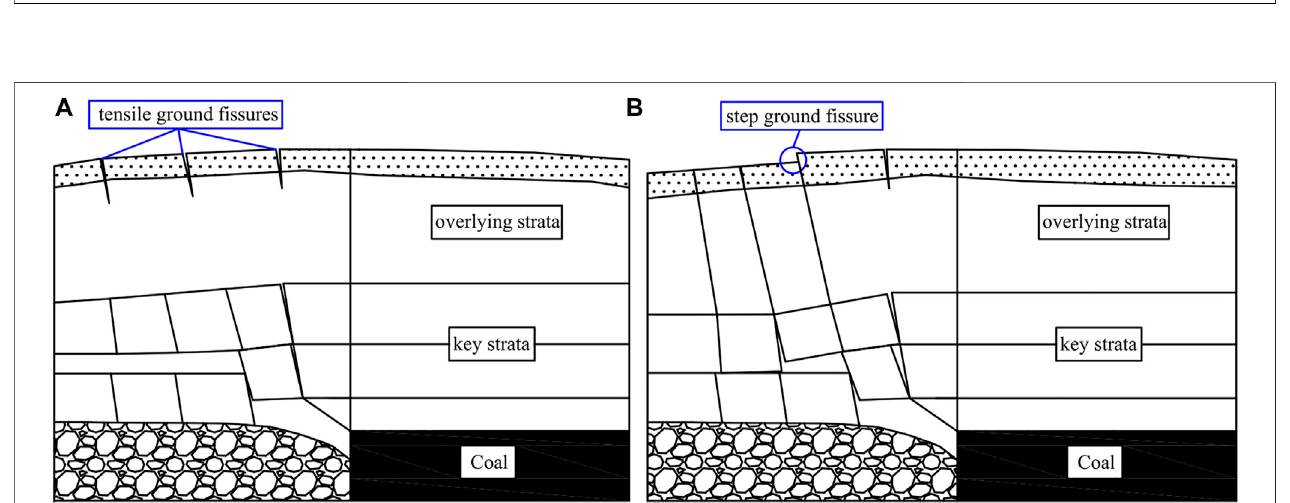
FIGURE 15 | (A) Formation process of tensile ground fi ssures. (B) Formation process of step ground fi ssures.